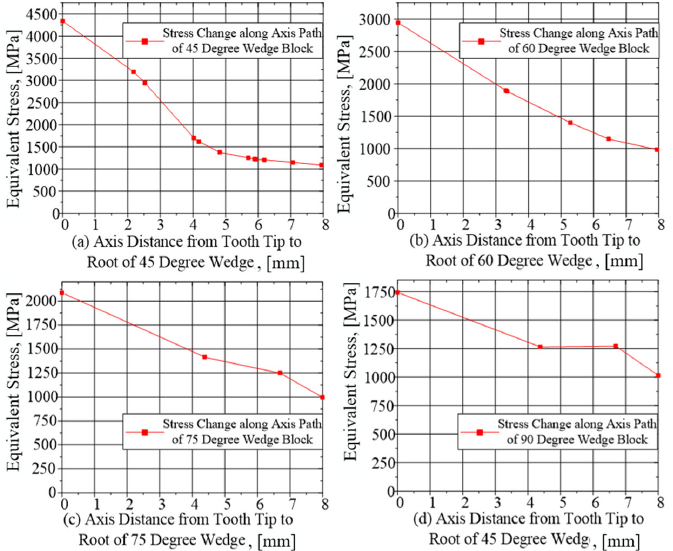
Figure 15. Stress Variation of Four Non-rigid Wedges along the Axis Path from Tooth Tip to Tooth Root with 45°, 60°, 75° and 90° Tooth Angle.